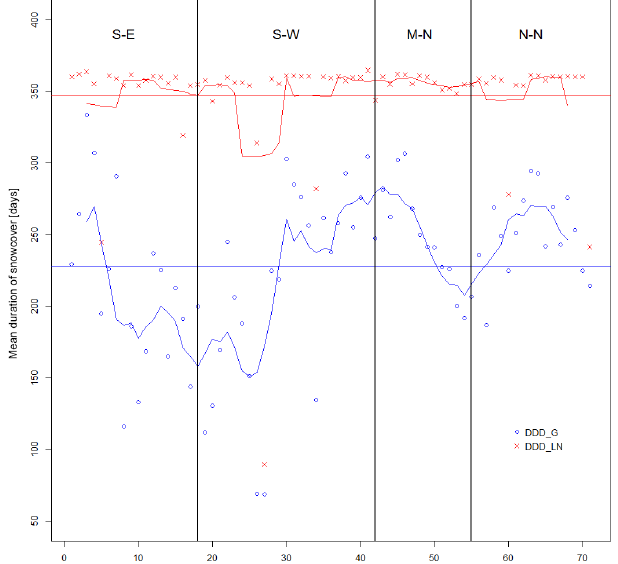
Figure 9. Mean annual days of snowcover in the catchments for DDD_LN (red) and DDD_G (blue). Moving averages are shown using the same colour code.